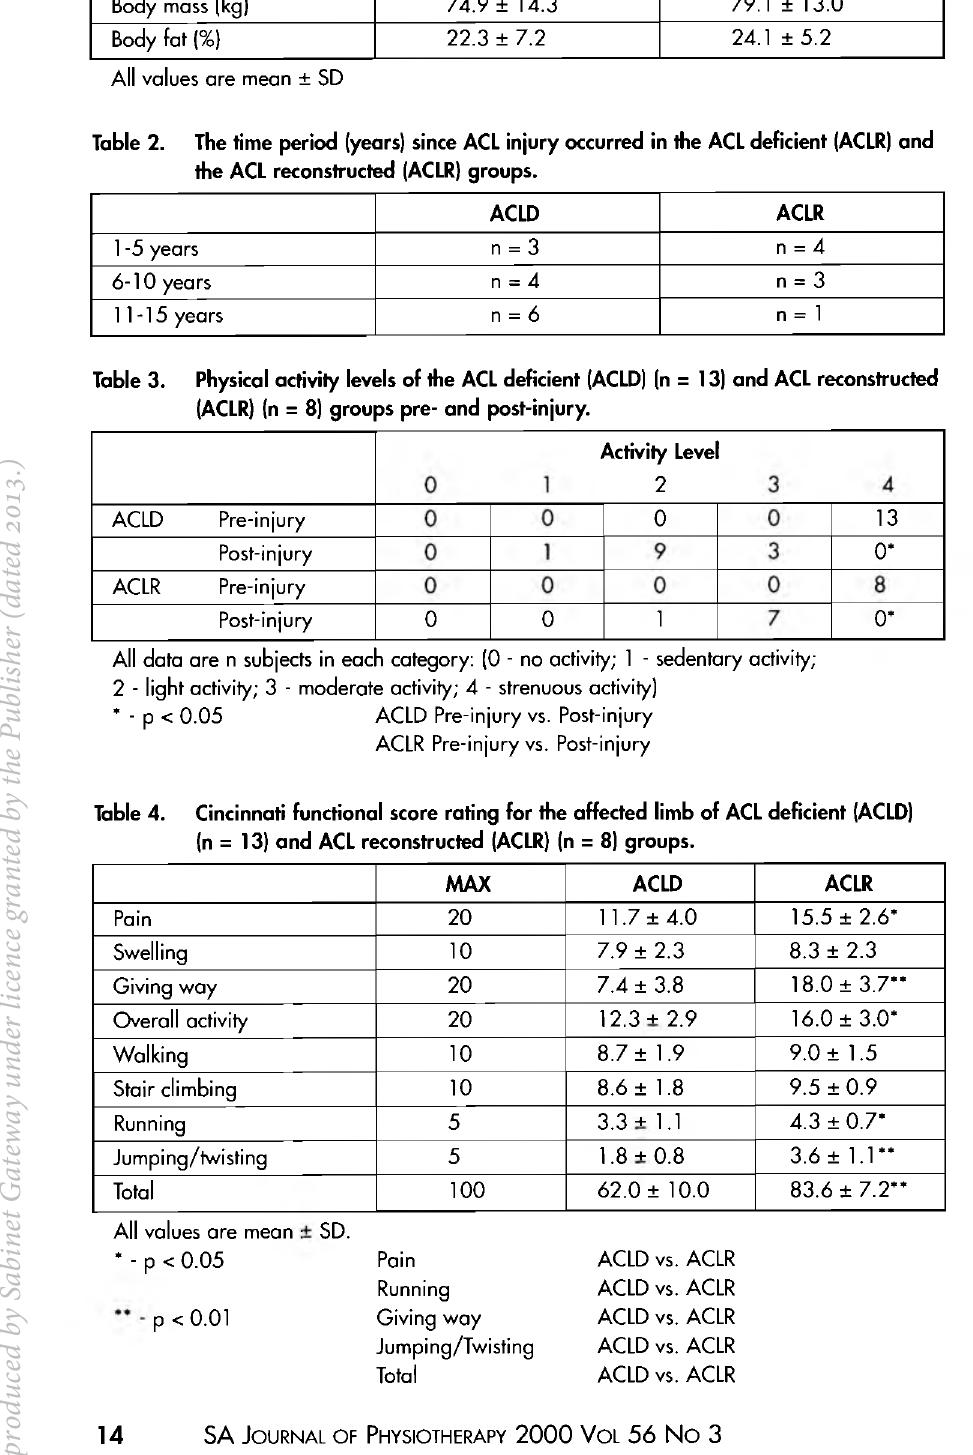
DescripHve data of the subjects in the ACL deficient (ACLD) (n = 13) and the ACL reconstructed (ACLR) (n = 8) groups.